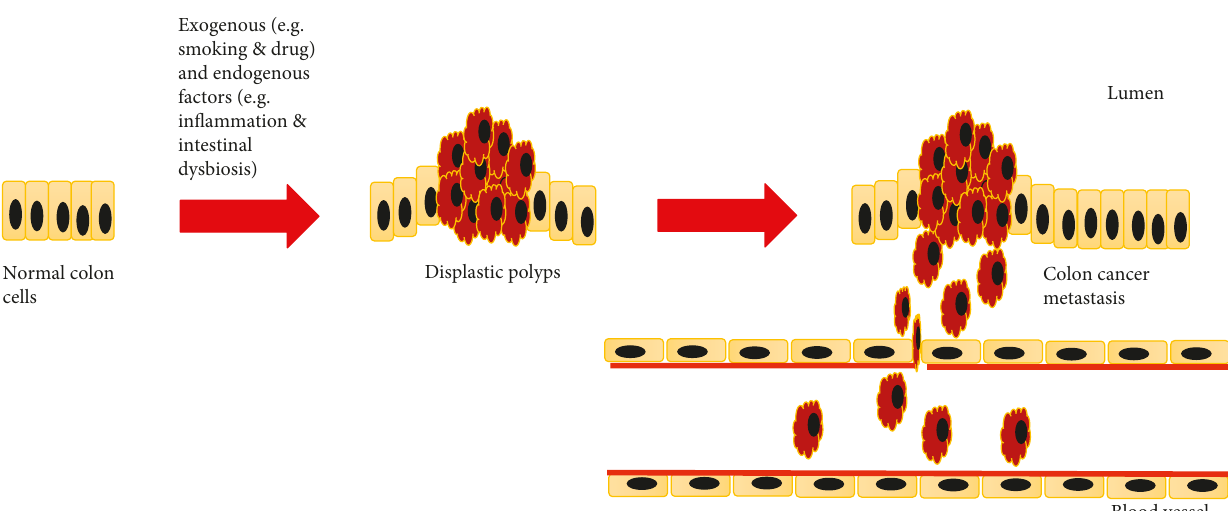
Figure 1: The metastasis of CRC in the presence of exogenous and/or endogenous factors (adapted and modi fi ed from Carini et al.